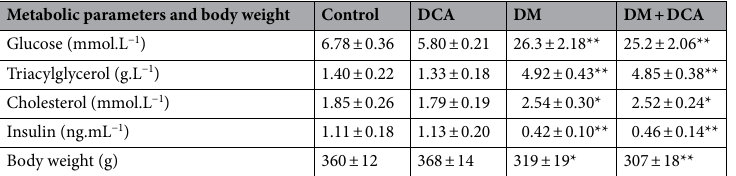
Table 1. Metabolic state and body weight of the experimental rats. All values are presented as the mean ± standard error of the mean (SEM). Control—untreated control group; DCA—control group treated with dichloroacetate; DM—diabetic group; DM + DCA—diabetic group treated with dichloroacetate * p < 0.05, ** p < 0.01 compared to Control.